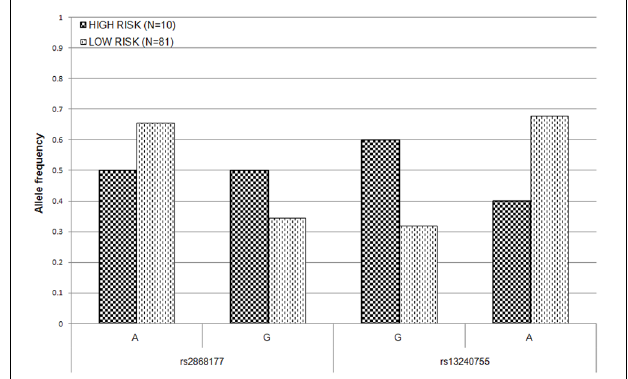
FIGURE 3 | Allele frequency distribution for the two POR SNPs associated with LVEF drop in high- and low- risk groups. Low risk group consists of patients with LVEF drop of less than 15% after daunorubicin therapy. High risk group consists of patients with at least 15% drop in LVEF after daunorubicin